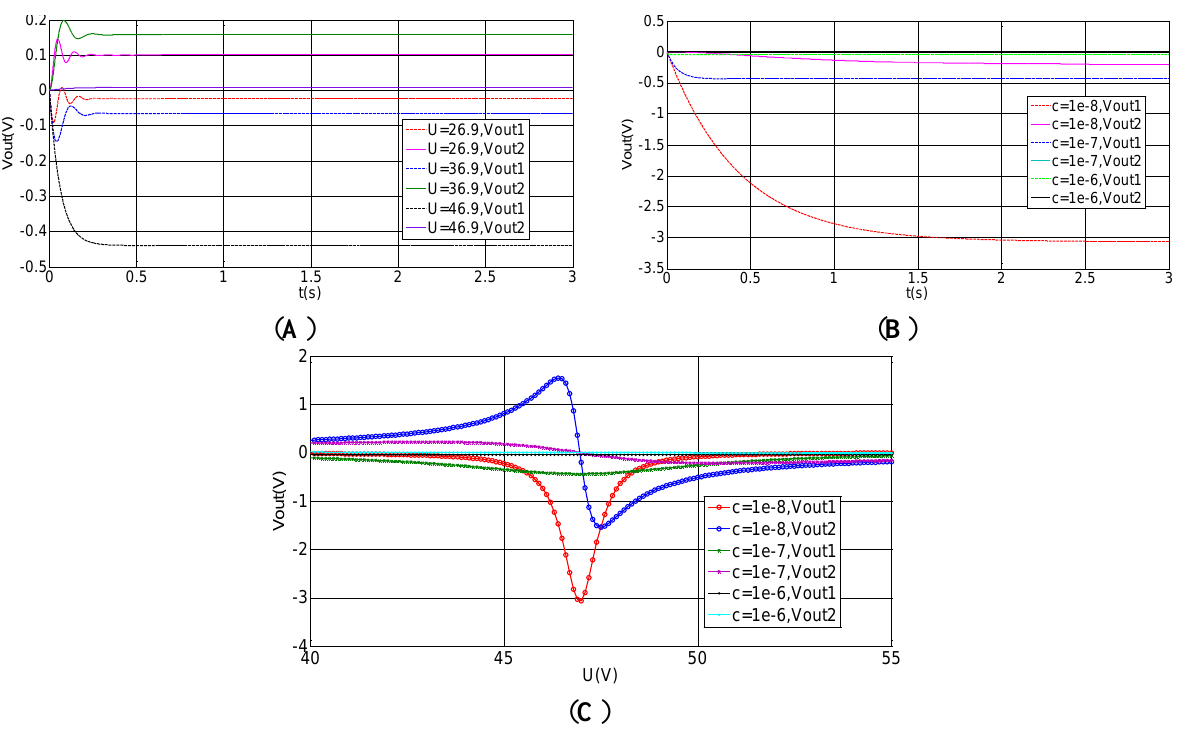
Figure 12. The open-loop system simulation. ( A ) The open-loop output at different tuning voltages. ( B ) The open-loop output with different damping coefficients (U = 46.9 V). ( C ) The curve of output voltage with the tuning voltage in different damping coefficients in the equilibrium